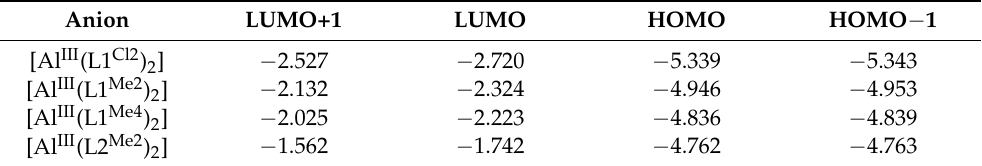
Table 3. Energy levels of frontier molecular orbitals of the Al III complex anions (eV).